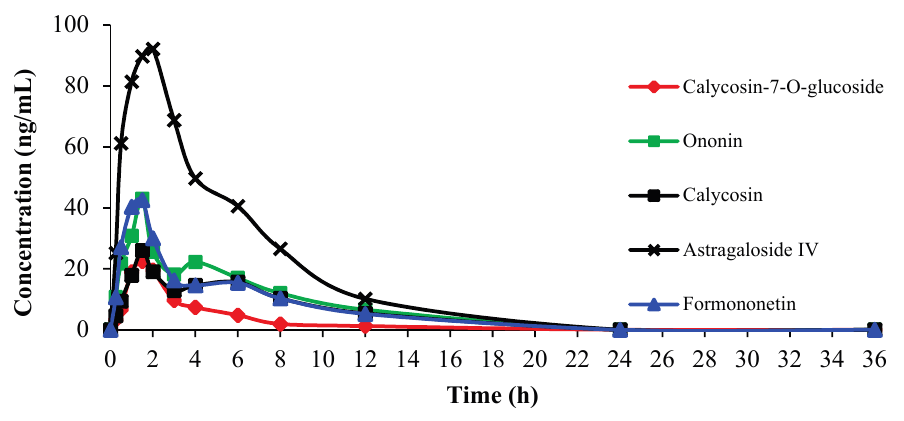
Figure 4. The mean plasma concentration-time profiles pf calycosin-7- O -glucoside, ononin, calycosin, formononetin and astragaloside IV in immunosuppressive mice plasma after oral administration of